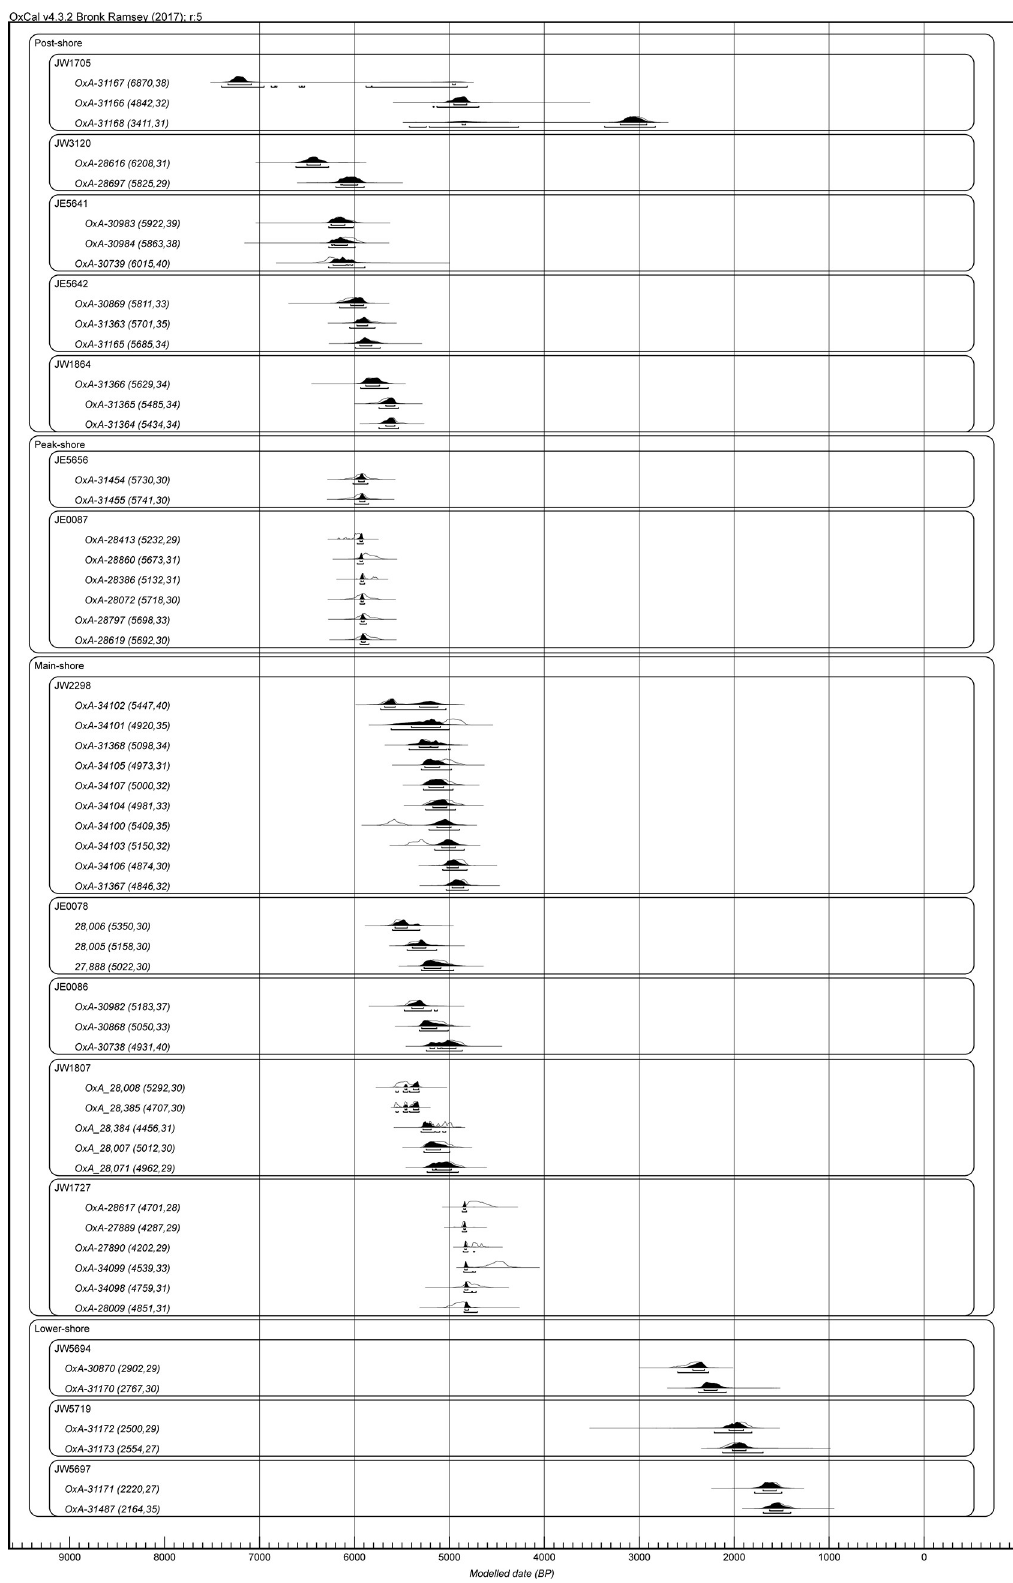
Fig 10. All radiocarbon dates grouped chronologically and by spatial group. Dating convention as in Table 1. https://doi.org/10.1371/journal.pone.0217596.g010 PLOS ONE | https://doi.org/10.1371/journal.pone.0217596 June 12,